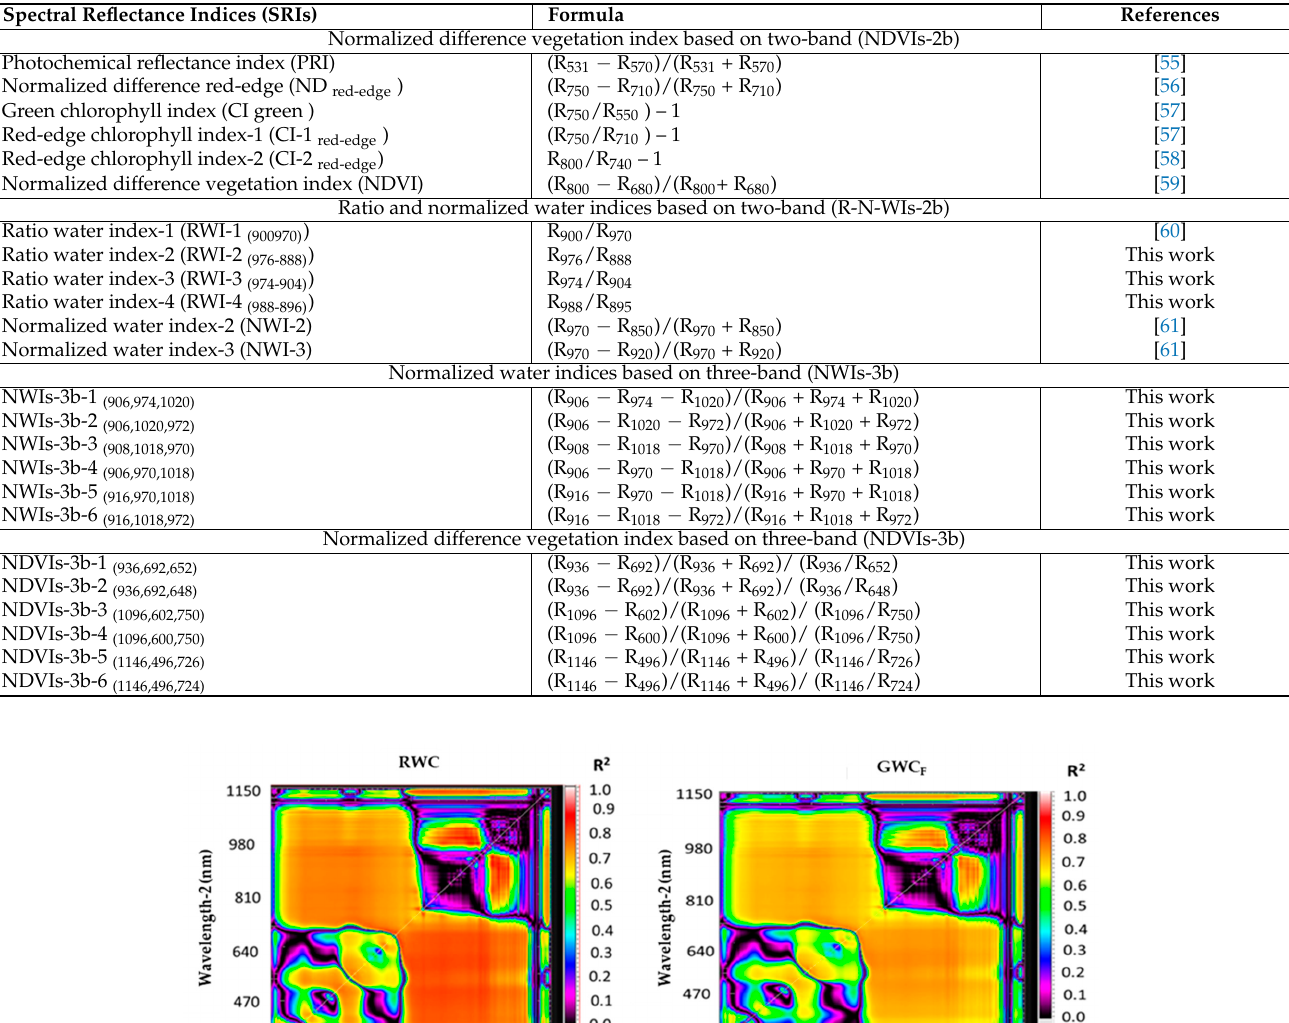
Table 2. Description of the different spectral reflectance indices tested in this study.